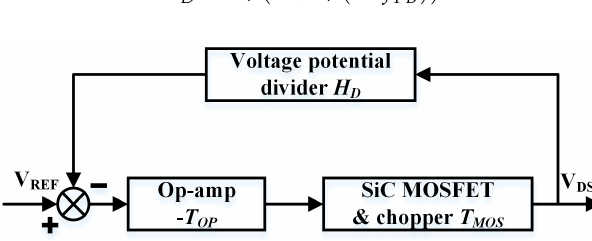
Figure 2. Control system representation of a MOSFET under closed-loop gate drive.